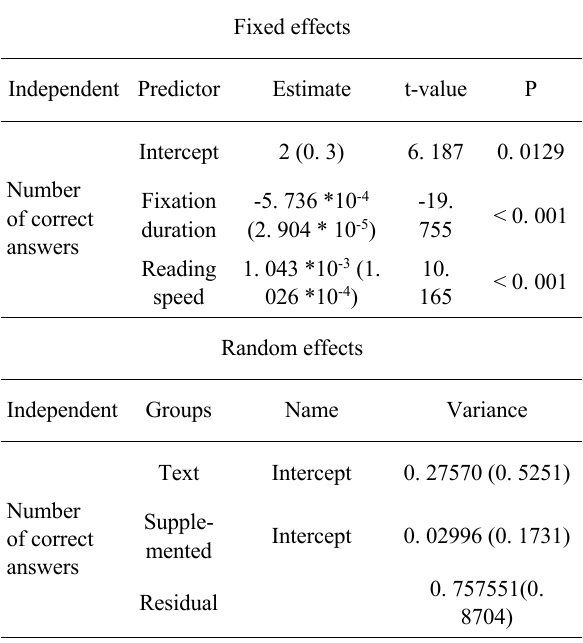
Table 3. Results of the LMM model to test the effect of fixation duration in reading, individual reading speed, the text read, and preliminary information adjustment (supplement) on the num- ber of correct responses to comprehension questions after read-